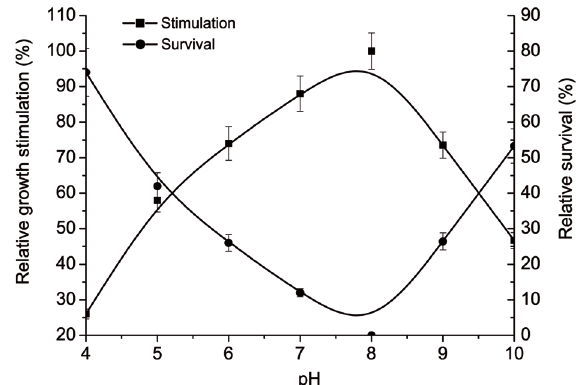
Figure 1 : Relative pH for growth stimulation and survival of D.